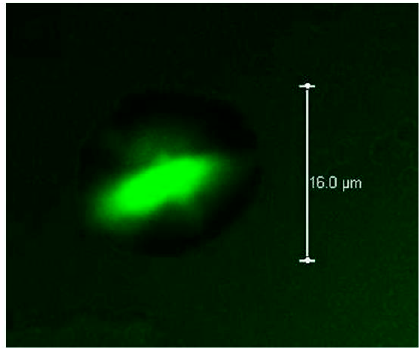
Figure 4. Confocal Laser Scanning Microscopy (CLSM) images. Protein autofluorescence showed in the center of beads (intense color). Conditions of injection flow, applied voltage, ethanol concentration, and CaCl 2 concentration are 0.163 mL/h, 14 KV; 87.5% ethanol, 15.5% CaCl 2 . Ghayempour and Mortazavi [30] worked with coaxial-electrospray systems previously, which included alginate (alginate has a gelling mechanism analogue to pectin). Accordingly, they found the